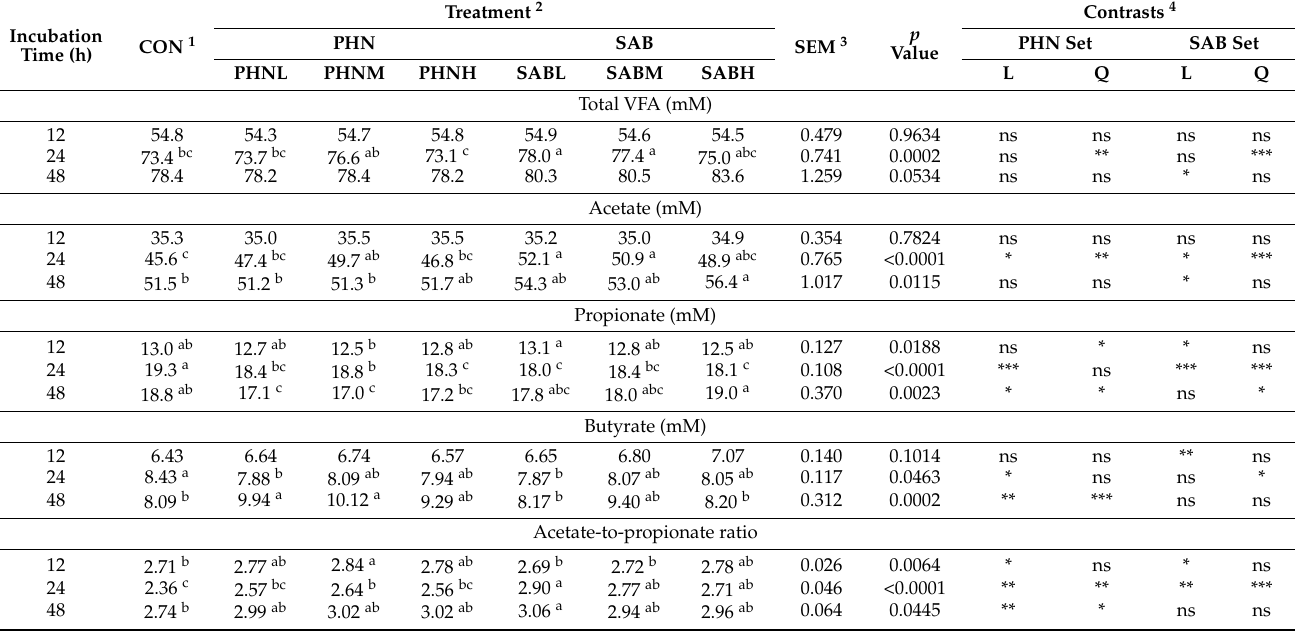
Table 6. Effects of bamboo leaves on volatile fatty acid profiles in in vitro incubation.